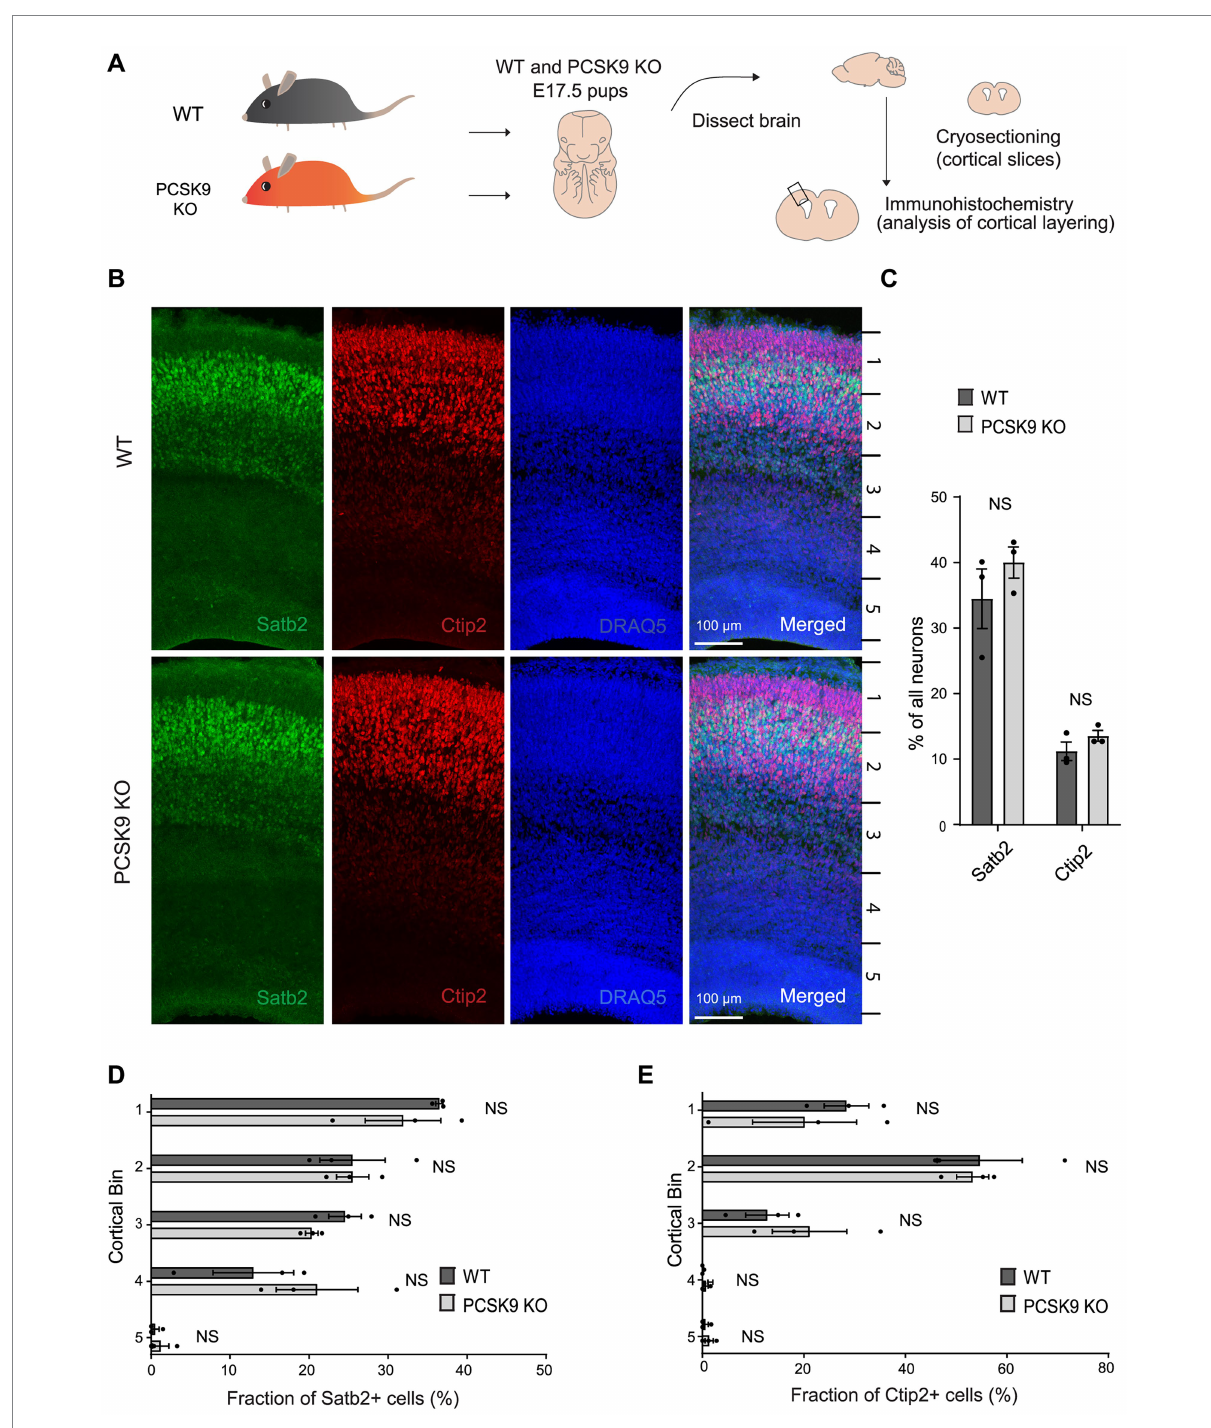
FIGURE 2 Lack of PCSK9 during development does not affect the fate of cortical progenitor cells. (A) Schematic representation of the experiment. (B) Representative images of immunostaining signals (Satb2, Ctip2, and DRAQ5) in WT and PCSK9 KO E17.5 cortices. (C) Quantification of the fraction of all neurons (DRAQ5 labelled) expressing indicated fate markers (Satb2, Ctip2) in WT and PCSK9 KO E17.5 cortical slices (see also Supplementary Table S1A). (D,E) Quantification of laminar distribution of cortical neurons labelled with Satb2 (D) or Ctip2 (E) fate markers in WT and PCSK9 KO E17.5 cortical slices (see also Supplementary Table S1B). Cortical bin – the maximum height of the cortical slice was divided into 5 bins of identical dimensions. Results on graphs are represented as average percent ± SEM. For statistical analyses two-way ANOVA with Bonferroni multiple comparison test was performed, alpha = 0.05. All p values were above 0.05 and considered non-significant; n = 3 WT, 3